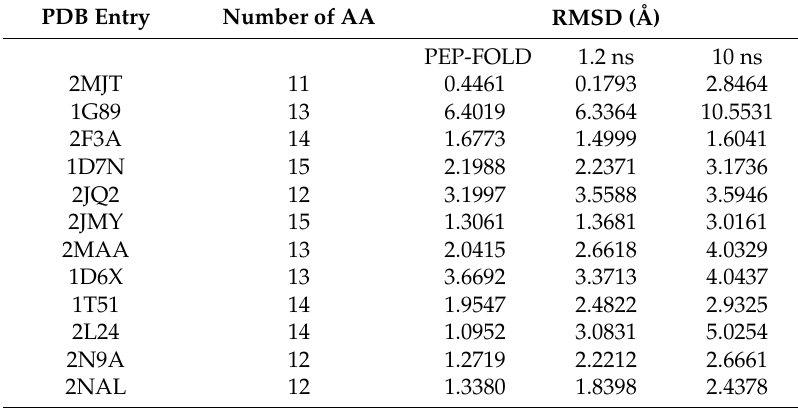
Table 4. The root mean square difference (RMSD) values resulting from the superposition of the peptide α -carbon atoms of the in silico predicted conformations (PEP-FOLD predicted and extracted from trajectory at 1.2 and 10 ns) on the corresponding experimental determined conformation extracted from the PDB. PDB